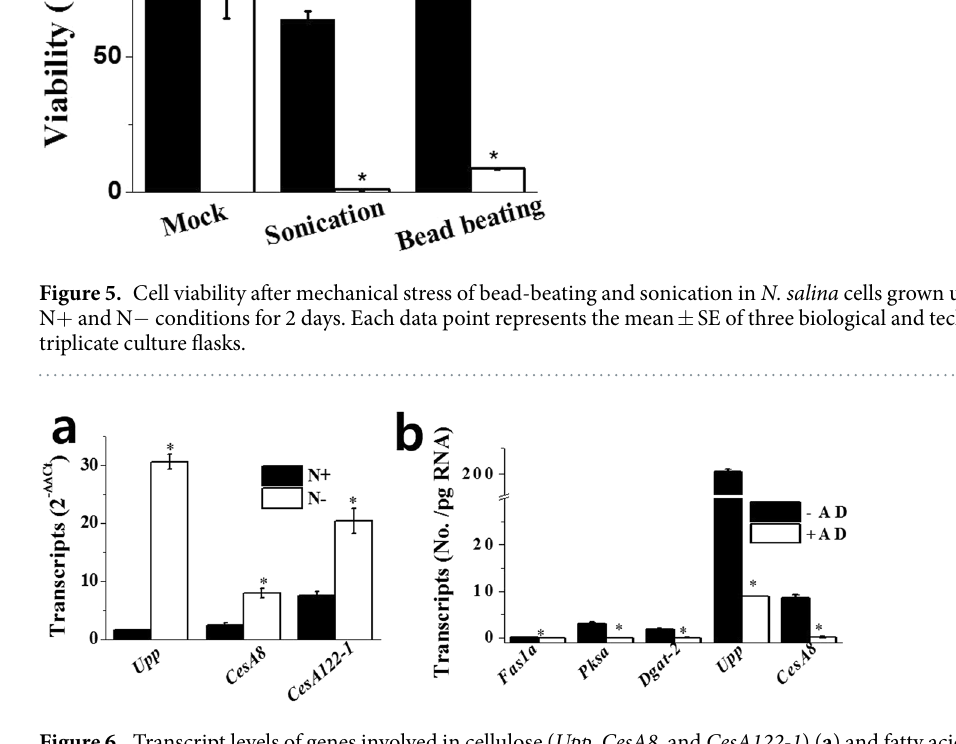
Figure 6. Transcript levels of genes involved in cellulose ( Upp , CesA8 , and CesA122-1 ) ( a ) and fatty acid ( Fas1a and Pksa ), lipid ( Dgat-2 ), and cellulose ( CesA8 ) ( b ) biosynthesis in N. salina cells grown under N + and N − conditions for 2 days. In ( b ), transcription inhibitor actinomycin D (AD, 100 μ g ml − 1 ) was included in N − media for 2 days prior to the onset of N − growth. Absolute copy numbers of the mRNA transcripts (number of copies/ng of total RNA) were determined by qRT-PCR analysis. Each data point represents the mean ± SE of three biological and technical triplicate culture